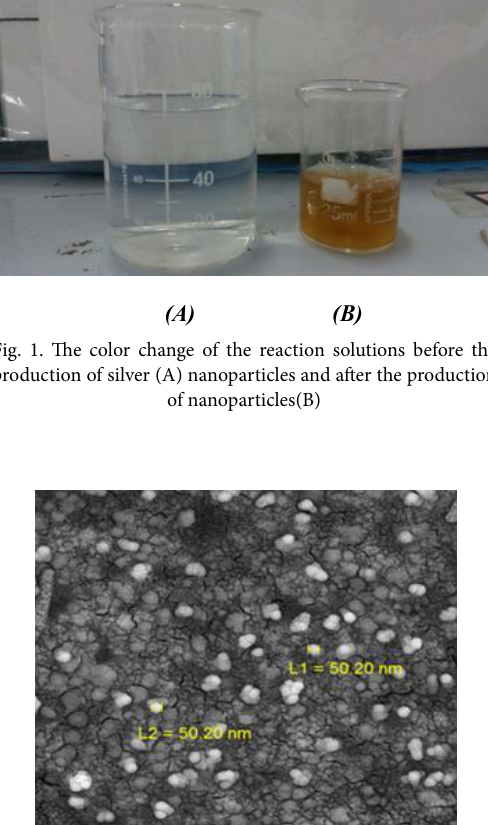
Fig. 4. X–ray diffraction patterns of synthesized AgNPs using Fig4. X – ray diffraction patterns of synthesized AgNPs using coffee residues coffee Fig. 3. SEM image of silver nanoparticles synthesized by coffe Fig3. SEM image of silver nanoparticles synthesized by coffe residues residues